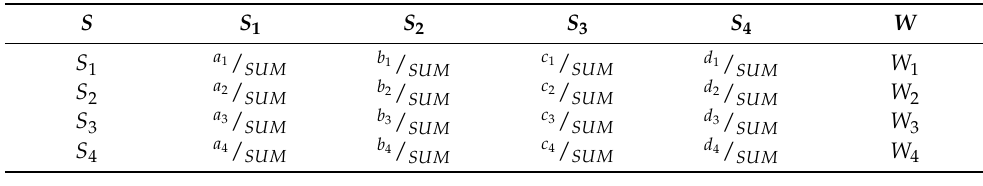
6. Calculating AW .